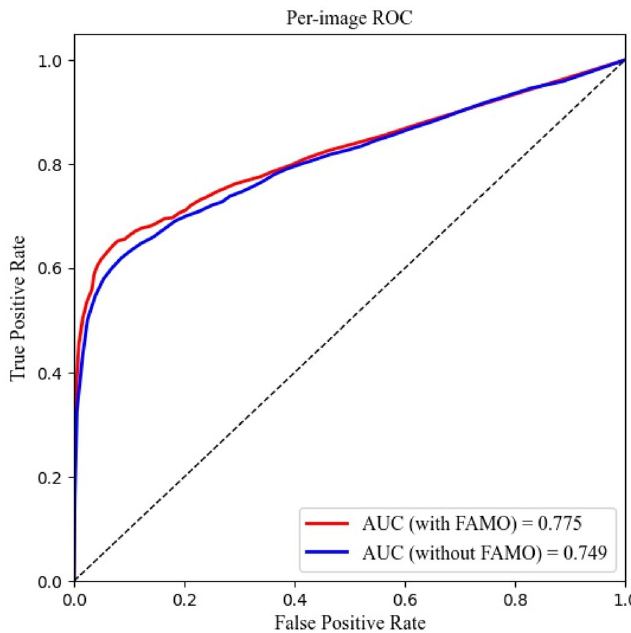
Figure 1. Per-image level ROC curve.